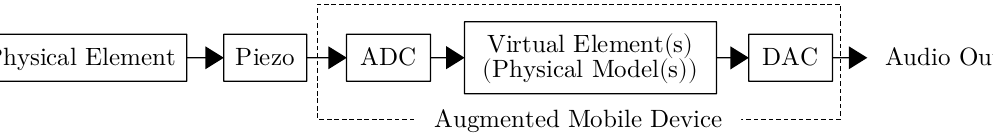
Augmented Mobile Device Figure 12. “Typical” acoustically driven mobile hybrid instrument